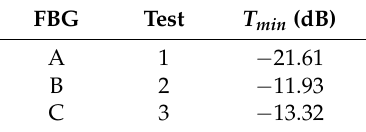
Table 2. Initial Transmissivity of the Three FBG Samples Used in These